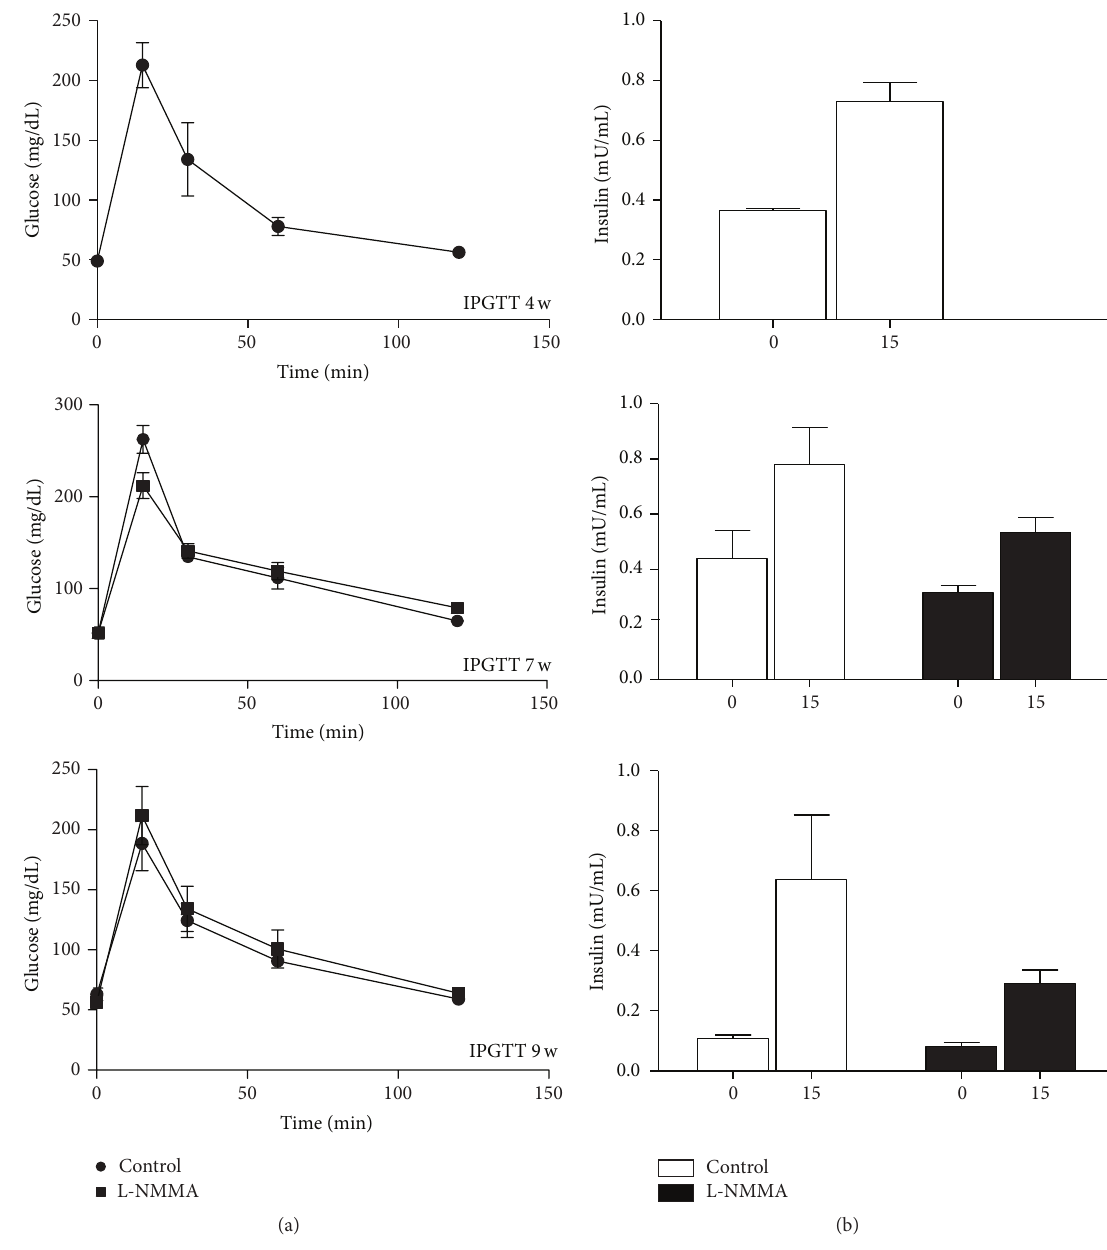
Figure 6: (a) IPGTT was performed in BB rats treated with vehicle (circle) or L-NMMA (square) at 4, 7, and 9 weeks of age. The results are presented as means ± SEM of glycemia (mg/mL) at the stated times after glucose injection in an 𝑛 = 5 animals. (b) plasma insulin was quantified in blood samples obtained from BB rats treated with vehicle (white bars) or L-NMMA (black bars) at 4, 7, and 9 weeks of age. The results are presented as means ± SEM of insulin concentration (mU/mL) at fasting and 15min after glucose injection in an 𝑛 = 5